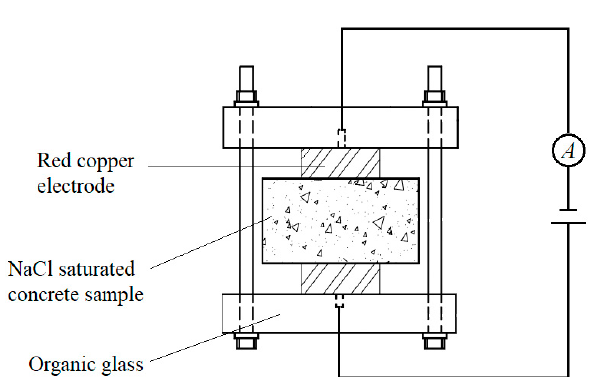
Figure 5. The schematic diagram of the test device of concrete conductivity method.